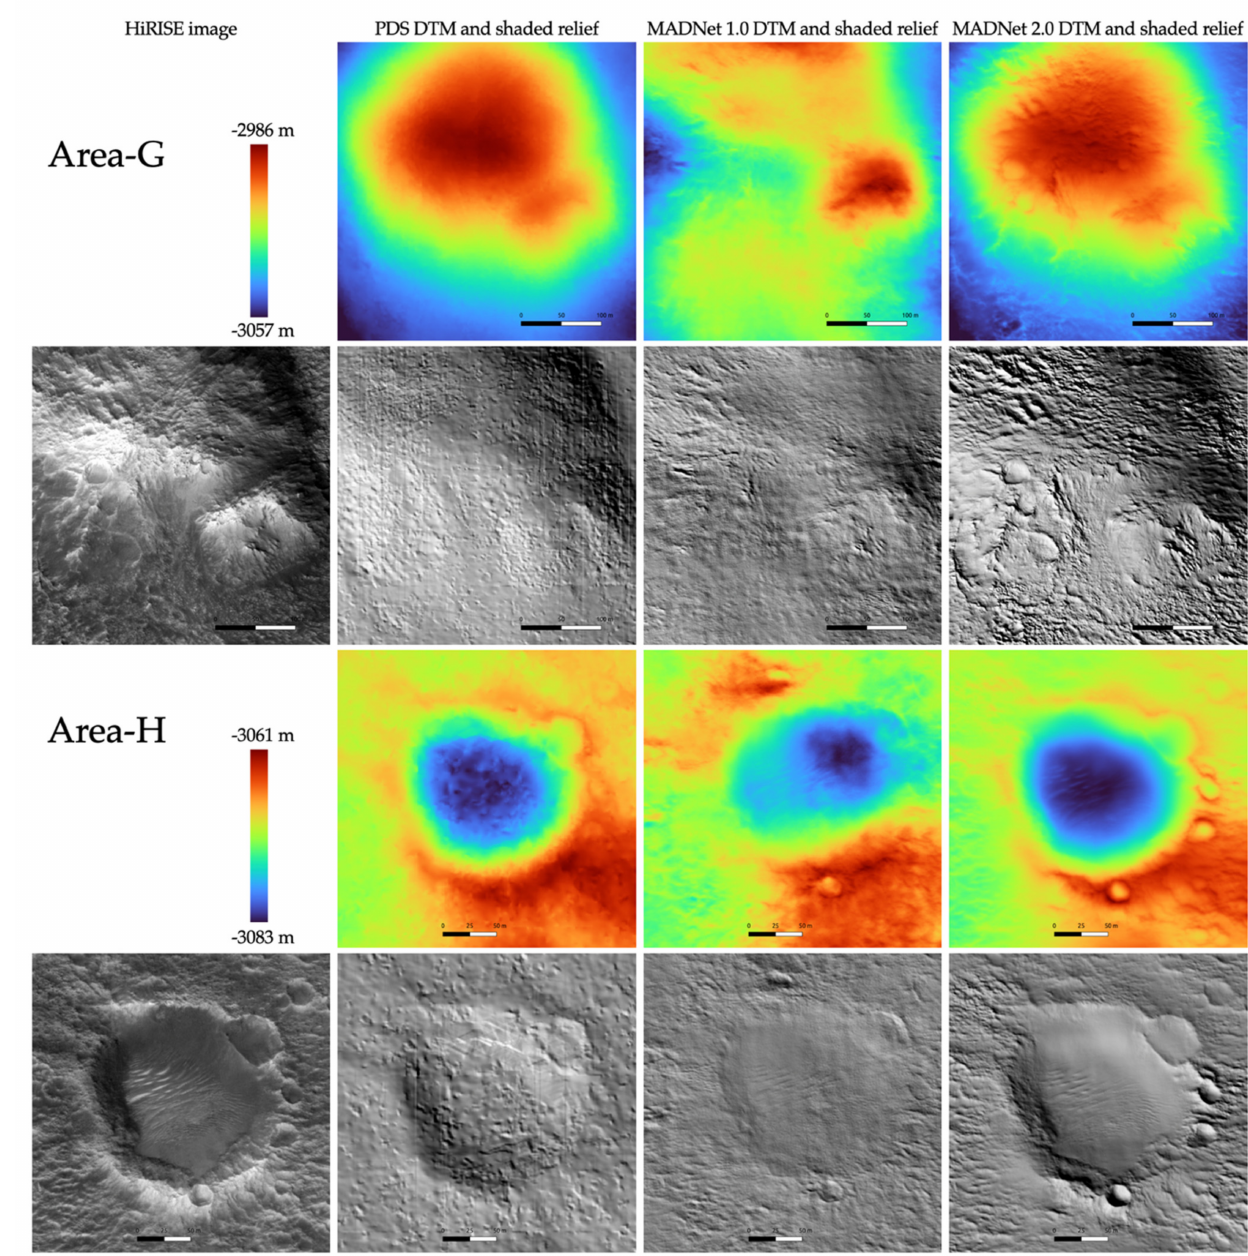
Figure 14. Examples of zoom-in views of the 1 m/pixel PDS HiRISE DTM, 50 cm/pixel MADNet 1.0 DTM, and 25 cm/pixel MADNet 2.0 DTM, produced from a single HiRISE image